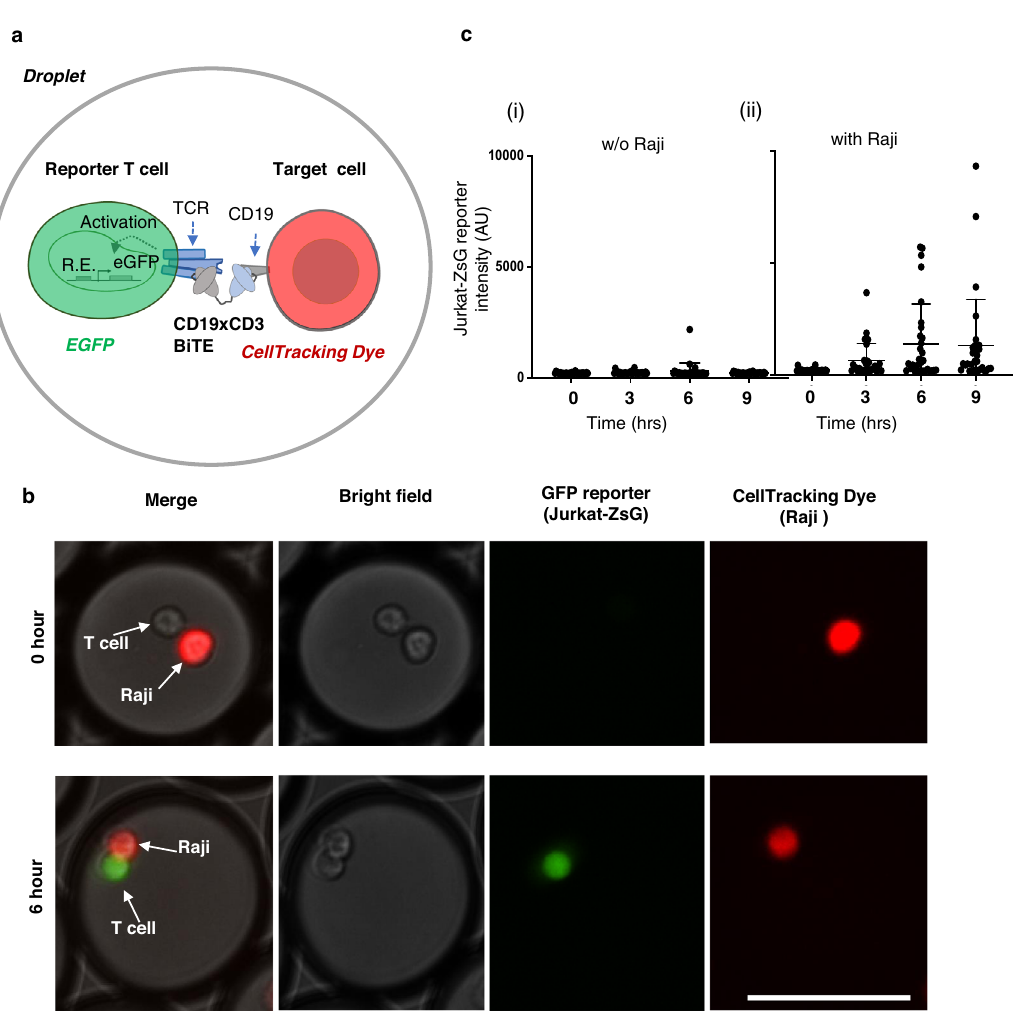
Fig. 3 BiTE mediated activation of Jurkat-ZsG reporter cells in droplets. a Illustrative mechanism of CD19xCD3 BiTE mediated T cell activation in the droplet assay. R.E. responsive element. b Microscopic images of activated Jurkat-ZsG reporter cells (expressing a GFP reporter) in the presence of Raji cell (CD19 + ) and a research-grade recombinant Blinatumomab in droplets; scale bar, 100 µ m. Green, ZsGreen reporter signal; Red, a cell tracking dye pre- labeled for Raji. c ZsGreen signal intensity change in Jurkat-ZsG cells added with 100 ng/ml Blinatumomab, without Raji cells (i) and with Raji cells (ii) over 0 – 9 h time-points post-incubation. ZsGreen intensity was quanti fi ed for randomly chosen droplets (obtained from one encapsulation experiment) at each time point. Data for each timepoint is presented as a scatterplot with mean ± SD error